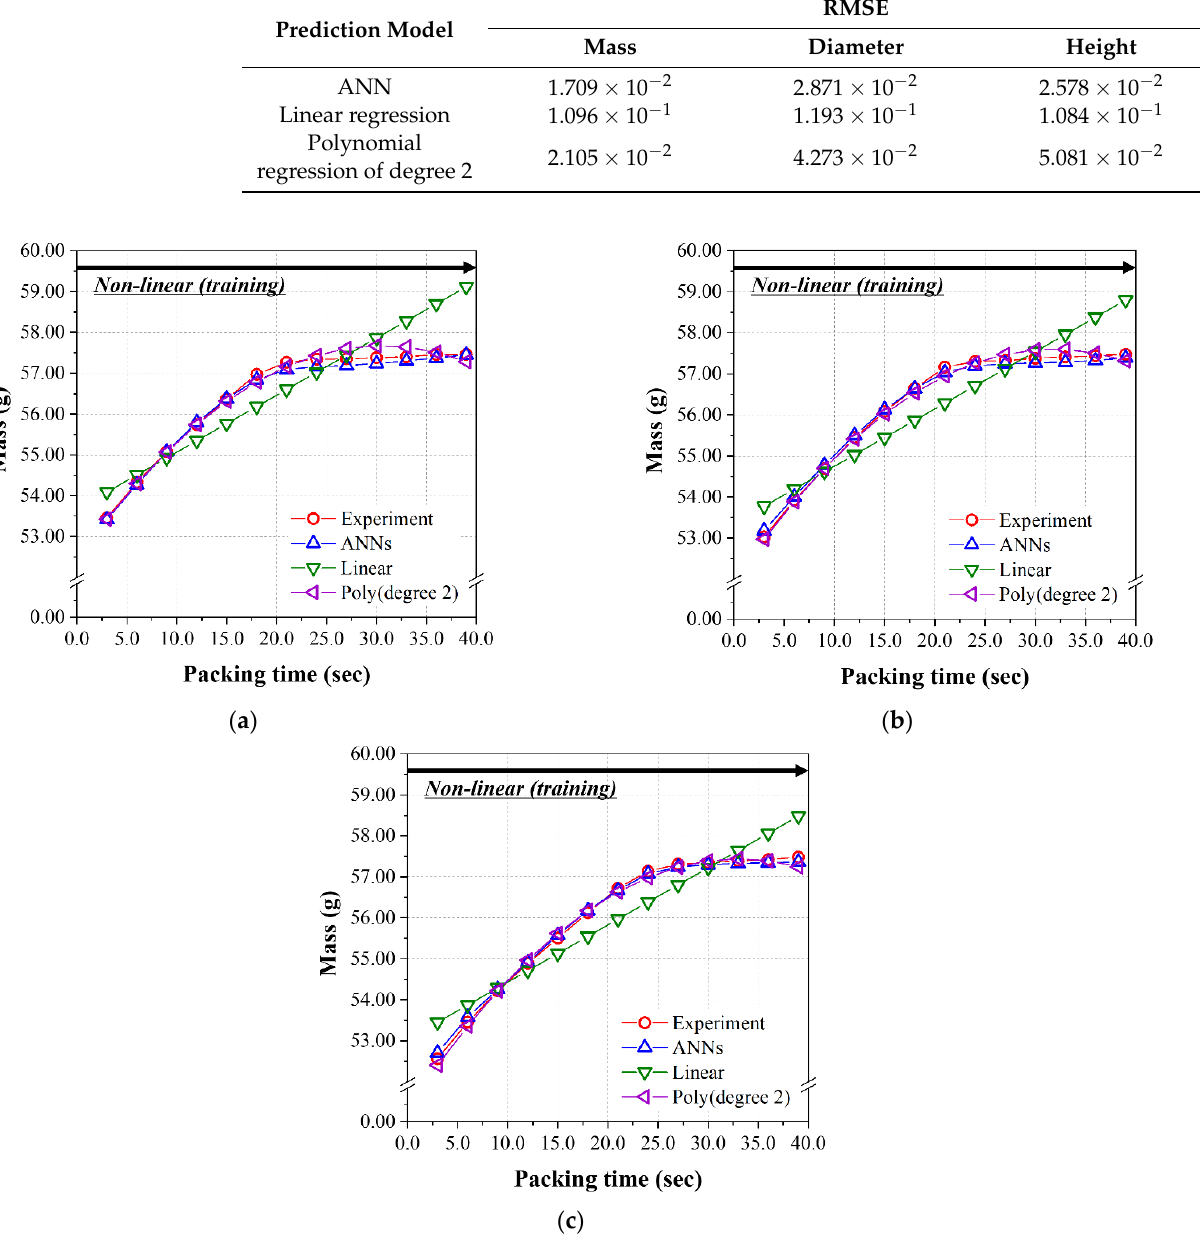
Figure 12. Predicted mass of the nonlinear group from Table A2 using the models learned by the nonlinear group (packing time was 3.0–39.0 s). Melt temperatures were ( a ) 200 °C, ( b ) 220 °C, and ( c ) 240 °C.